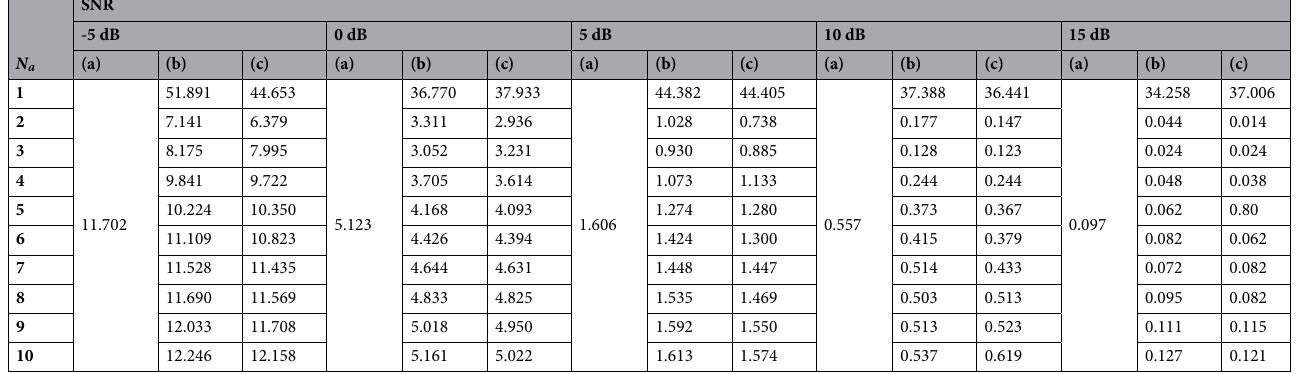
2 MUSIC with different SNR values and array order N a